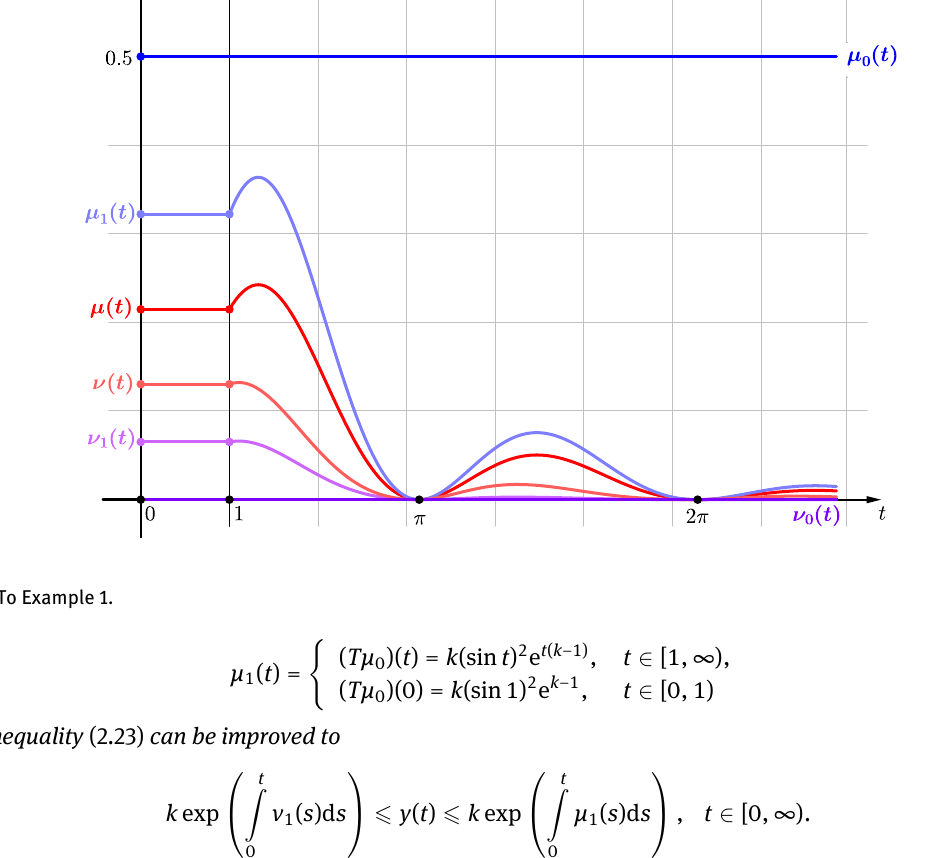
Fig. 3: To Example